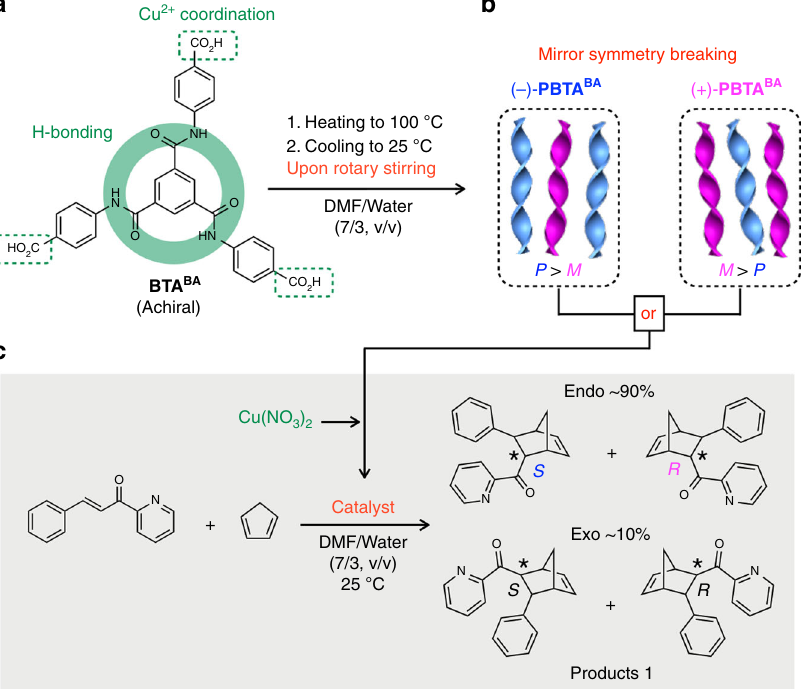
Fig. 1 Mirror symmetry breaking of helical supramolecular nanoribbons for asymmetric catalysis. a , b Molecular structure of the achiral BTA BA monomer and schematic representation of the preparation of helical PBTA BA nanoribbons with either ( P )- or ( M )-dominant helical handedness by applying rotary stirring during the cooling process of a DMF/water solution of BTA BA . ( P )- and ( M )-dominant PBTA BA display negative (( − )- PBTA BA ) and positive (( + )- PBTA BA ) CD signs at 316 nm, respectively. c Diels – Alder cycloaddition reaction between aza-chalcone and cyclopentadiene catalyzed by Cu 2 + in combination with ( − )- PBTA BA or ( + )- PBTA BA . The reaction affords the endo isomer preferentially (~90%). The ( S )-endo and ( R )-endo enantiomers were obtained preferentially when ( − )- PBTA BA and ( + )- PBTA BA were used,